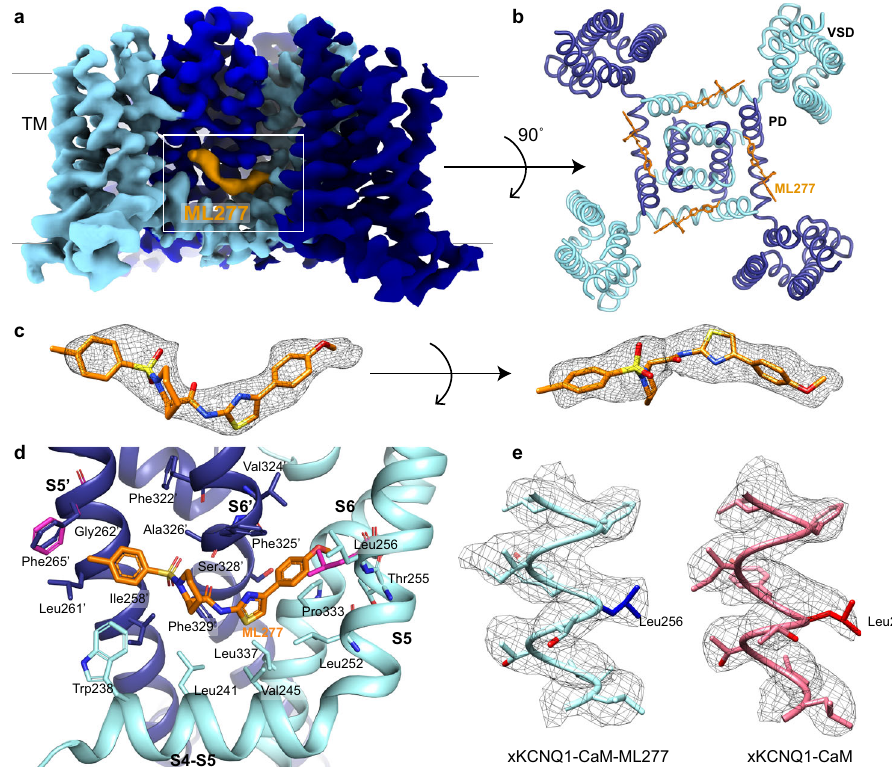
Fig. 2 ML277 binding to xKCNQ1-CaM. a The cryo-EM density map for xKCNQ1-CaM-ML277 with the density for ML277 indicated in orange. The density map is cut off at the TM region for clarity. b Top view of xKCNQ1-CaM-ML277 from the extracellular side is shown with ML277 (orange) bound in its hydrophobic pocket. The structure is clipped in the frontal plane at the level of the binding site for clarity. c Isolated density (5x rmsd) for ML277 is shown as a mesh with the ML277 docked inside in the orientation with the highest map-to-model correlation coef fi cient. d Enlarged side view of the ML277 binding pocket formed by the S4-S5 linker helix, the transmembrane spanning S5 and S6 helices from one protomer (light blue) and the S5 ′ and S6 ′ from an adjacent protomer (dark blue). The position of the side chain of Leu256 and the possible rotation of the phenyl ring of Phe265 ′ in the xKCNQ1-CaM structure are shown in pink. e Comparison of the density map (contour level at 5x rmsd) for xKCNQ1-CaM and xKCNQ1-CaM-ML277 focused on the S5